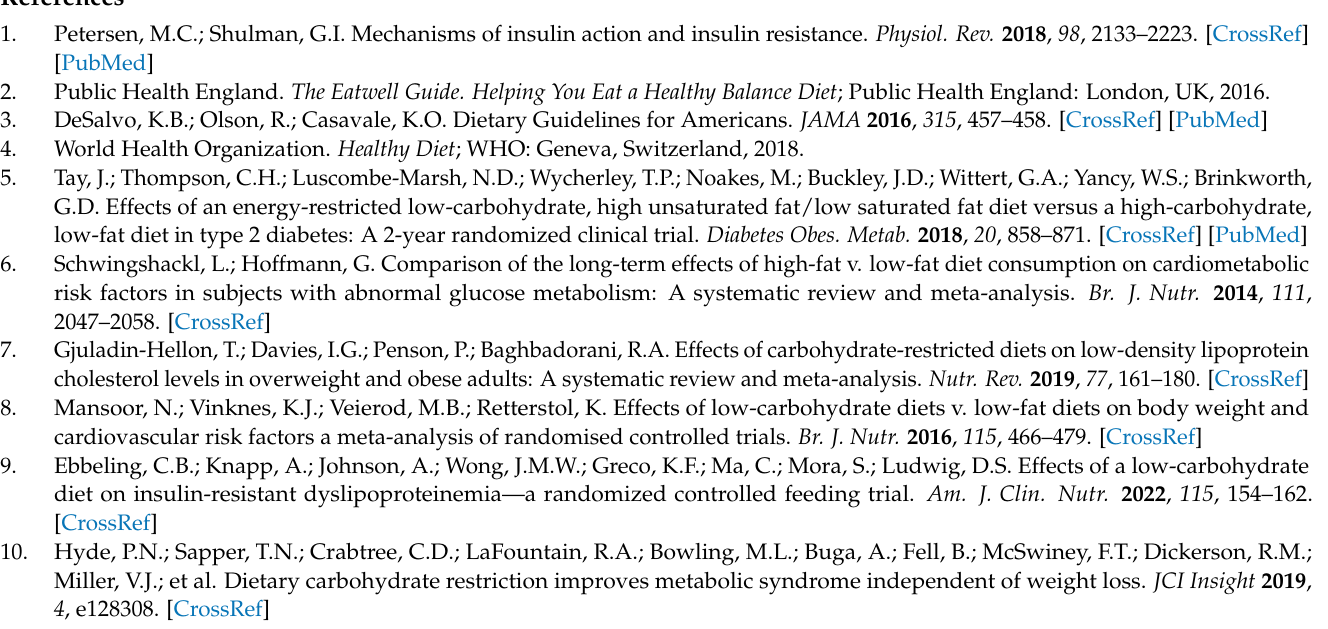
scoring system; Table S2: Per protocol analysis; Table S3: ANCOVA analysis; Table S4: Changes in dietary composition; Table S5: Changes in anthropometric variables and biochemical markers of metabolic health; Table S6: Changes in in 78 metabolites following a LCHF and HCLF diet after 8